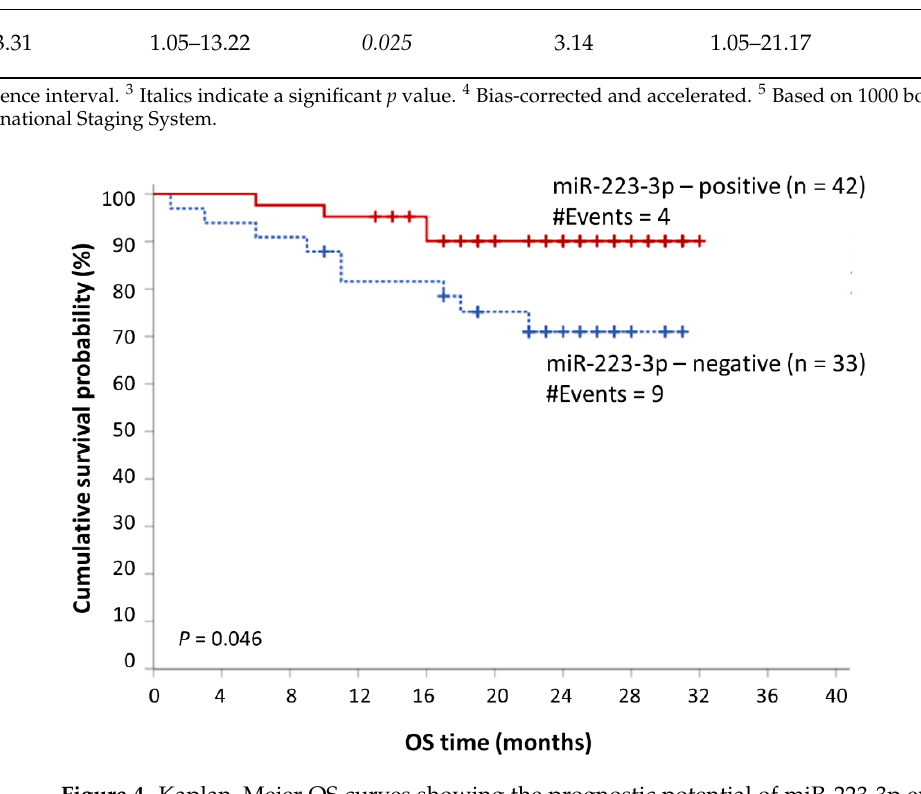
Figure 4. Kaplan-=–Meier OS curves showing the prognostic potential of miR-223-3p expression in CD138+ plasma cells of MM patients. CD138+ plasma cells of MM Table 2. Univariate and multivariate Cox regression analyses, regarding MM patients’ overall sur- vival (OS).